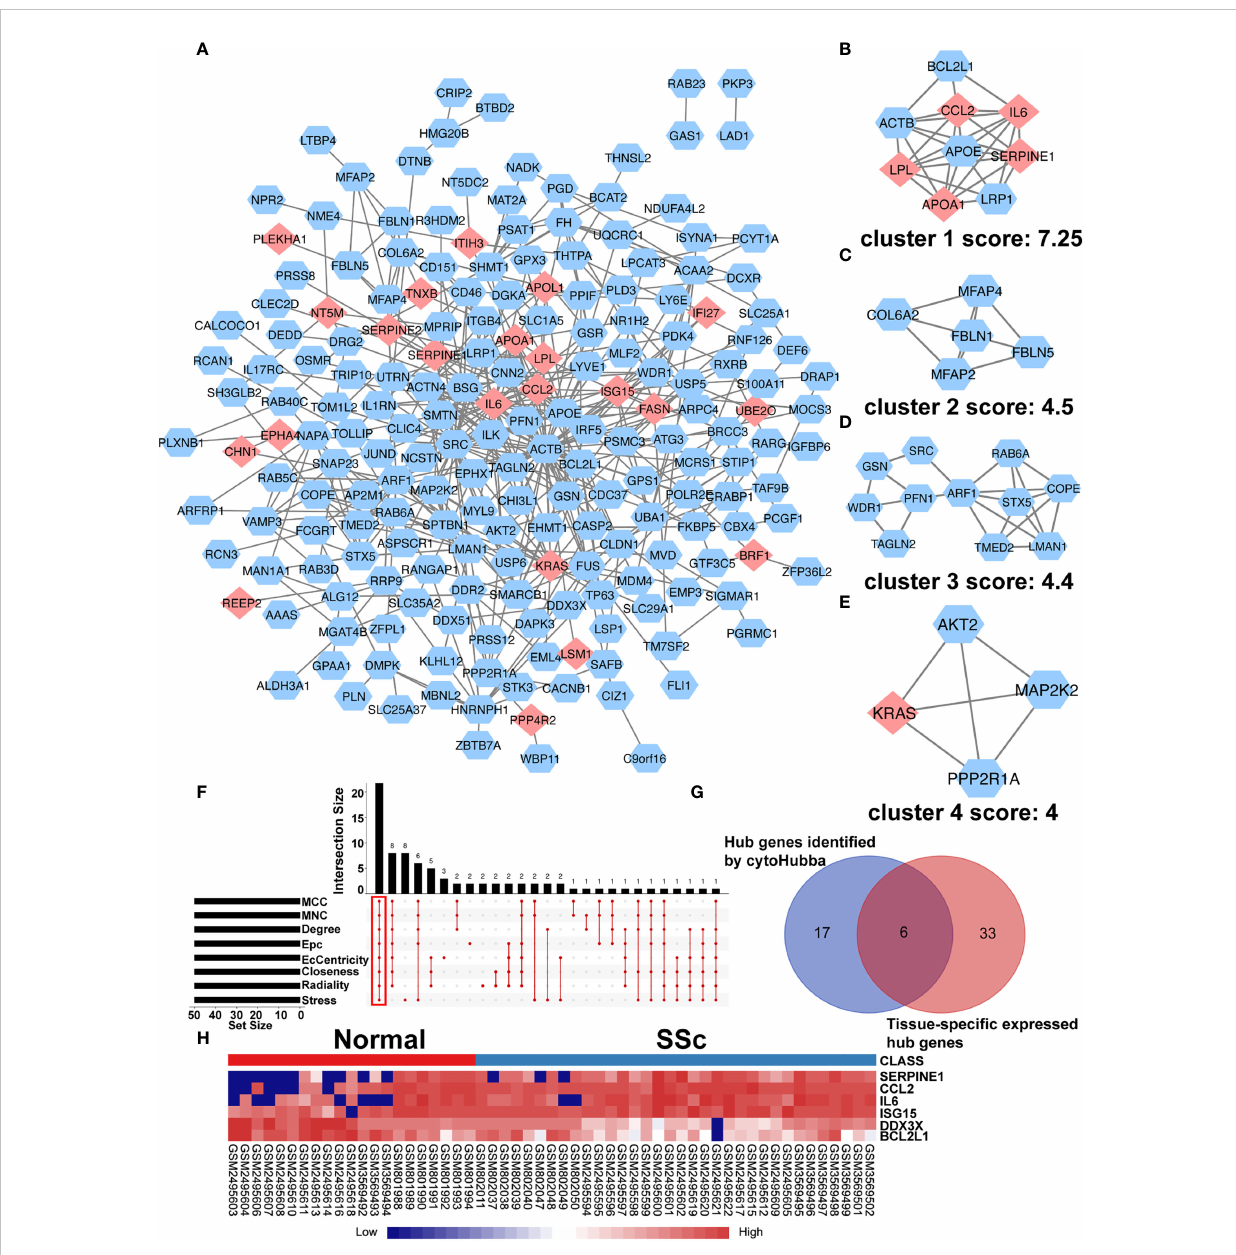
FIGURE 3 PPI network of DEGs and Identi fi cation of Hub Genes. (A) The interaction network between proteins was constructed using cytoscape. Each node represents a protein, while each edge represents one protein – protein connection. Pink diamonds represent the upregulated genes, and blue octagons represent the downregulated genes. Cluster modules are extracted by MCODE. Cluster 1 (B) received the best cluster score (score: 7.25, 9 nodes and 27 edges), whereas Cluster 2 (C) came in second place (score: 4.5, 5 nodes and 9 edges), Cluster 3 (D) came in third (score: 4, 11 nodes and 23 edges), and Cluster 4 (E) came in fourth (score: 4, 4 nodes and 6 edges). (F) Eight algorithms to identify hub genes by R package “ UpSet ” . (G) A Venn diagram was used to identify the six tissue-speci fi c expressed hub genes in SSc. (H) The heatmap showed the expression of six tissue- speci fi c expressed hub genes using merged microarray